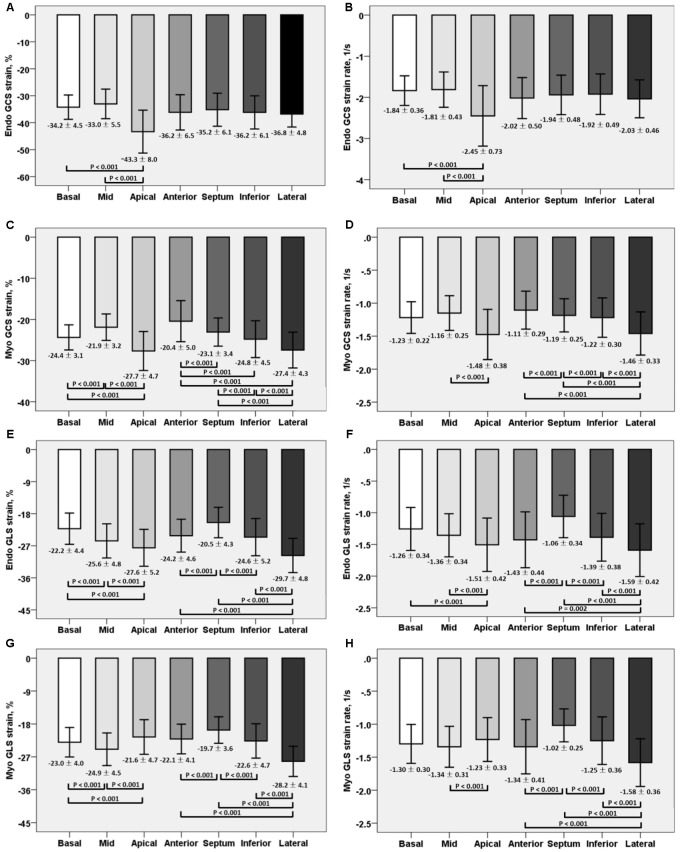
Comparison of endocardial circumferential strain and strain rate (A) and (B); myocardial circumferential strain and strain rate (C) and (D); endocardial longitudinal strain and strain rate (E) and (F); and myocardial longitudinal strain and strain rate (G) and (H) at basal, mid and apical levels; anterior, septum, inferior and lateral walls.